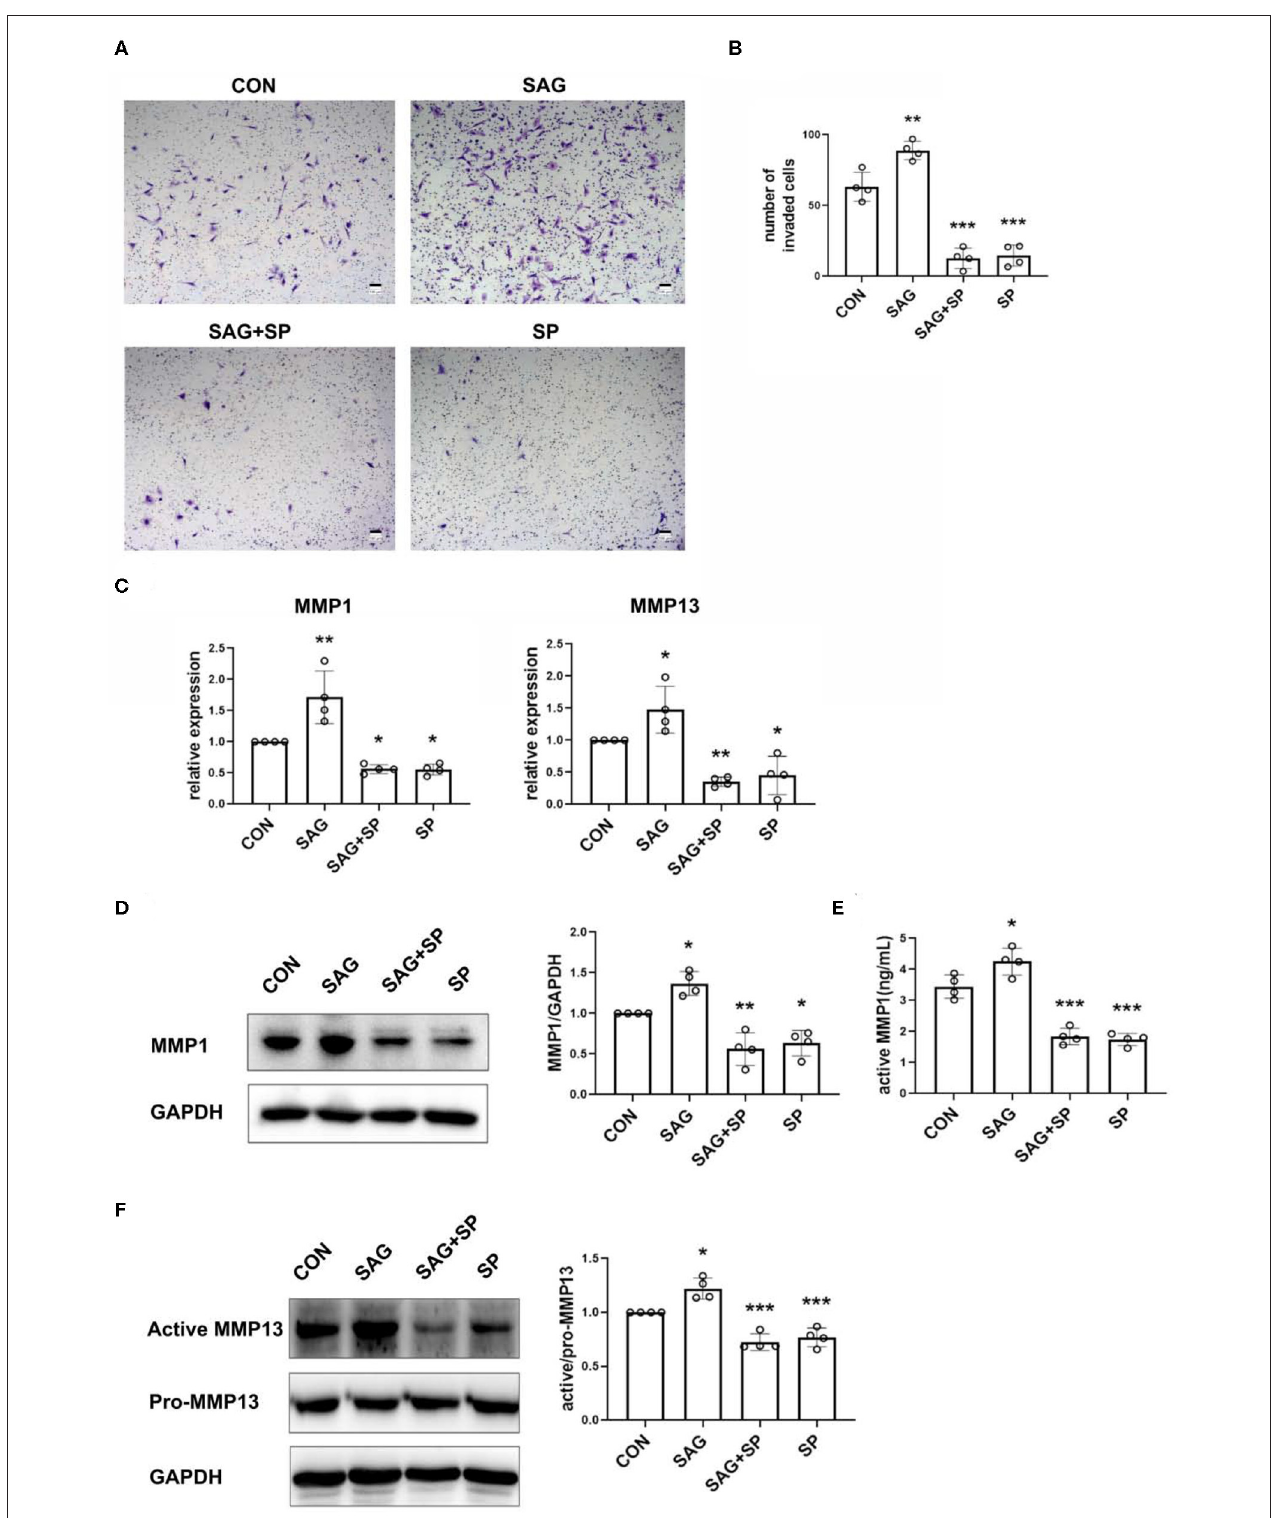
FIGURE 5 | SHH agonist increases FLSs invasion via JNK. (A,B) FLSs invasion was evaluated by Boyden chambers with matrigel-coated membrane used in the system ( n = 4). FLSs were planted in the upper chambers. DMEM containing 10% FBS, SAG (1 µ M) with or without SP600125 (20 µ M) was added to the